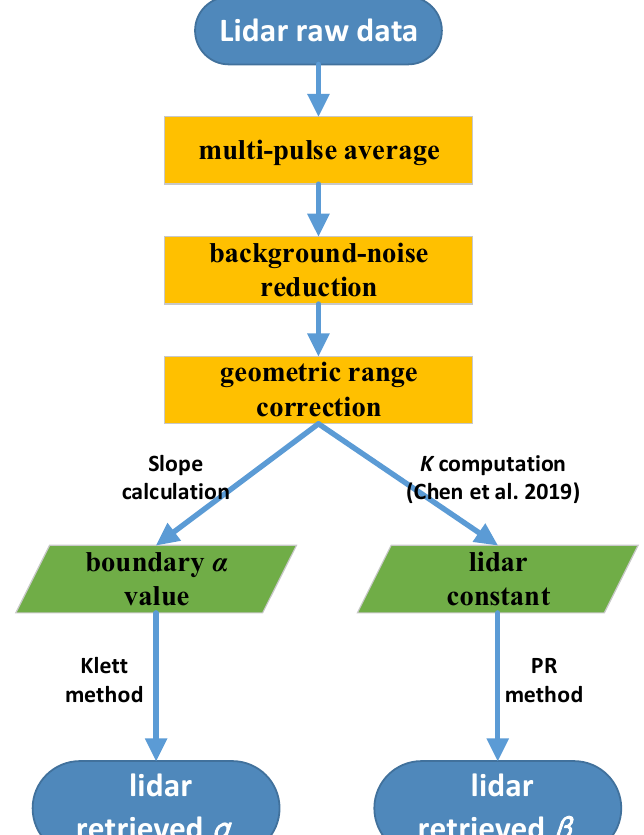
Figure 3. Flow chart showing the inversion process.